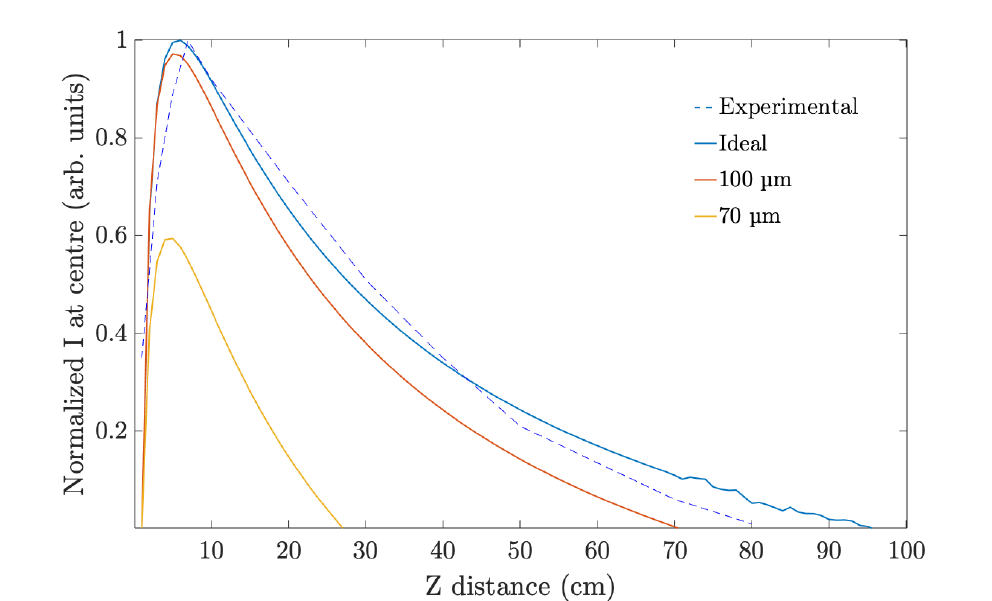
Figure 8. Normalized intensity at the center of a simulated axicon as a function of the distance for different material: an ideal material; a 100 µ m thickness material and a 70 µ m thickness